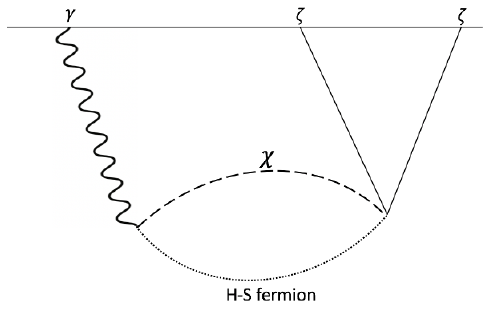
Figure 2. Diagram contributing to h (cid:13)(cid:16)(cid:16) i